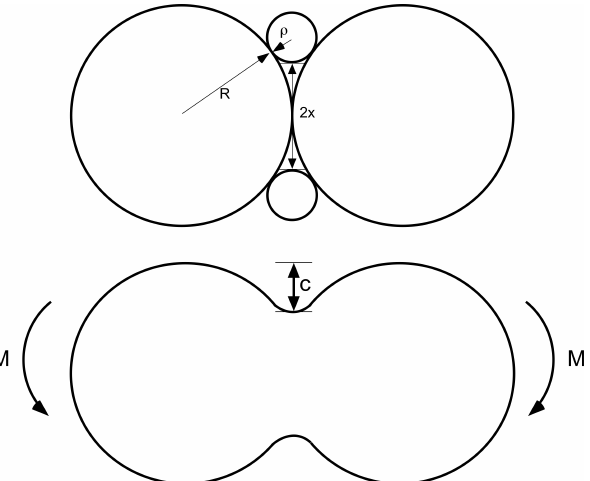
Figure 5. Scheme of two overlapping particles, which built a neck with a radius of curvature ρ during growth. The neck diameter, which can be measured for instance from SEM pictures (see [3]), is denoted as 2 x